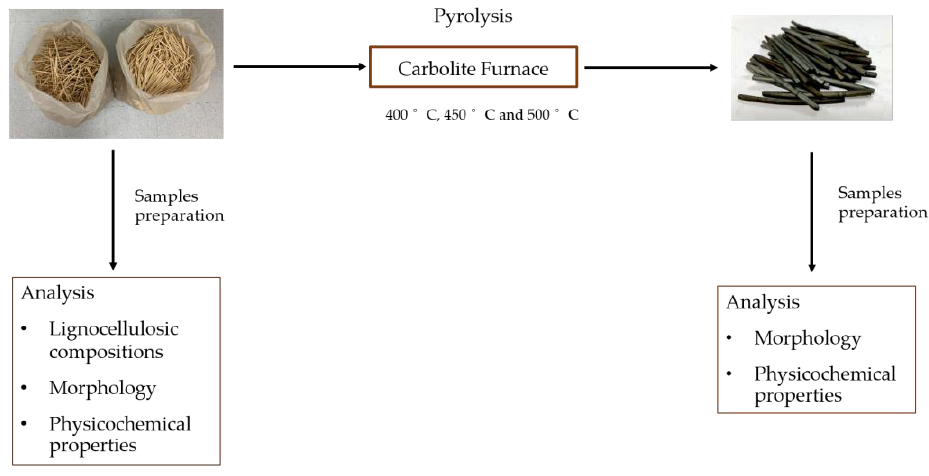
Figure 1. Feedstock and biochar